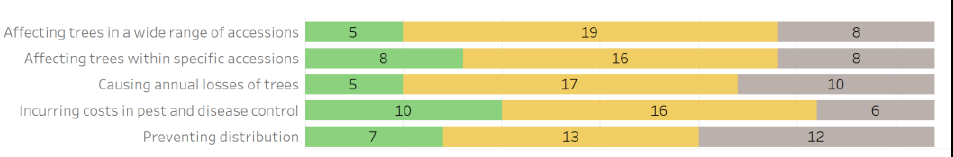
Figure 6. The number of collections that have major ( green ), minor ( yellow ), and no ( gray ) effects from pests and pathogens.